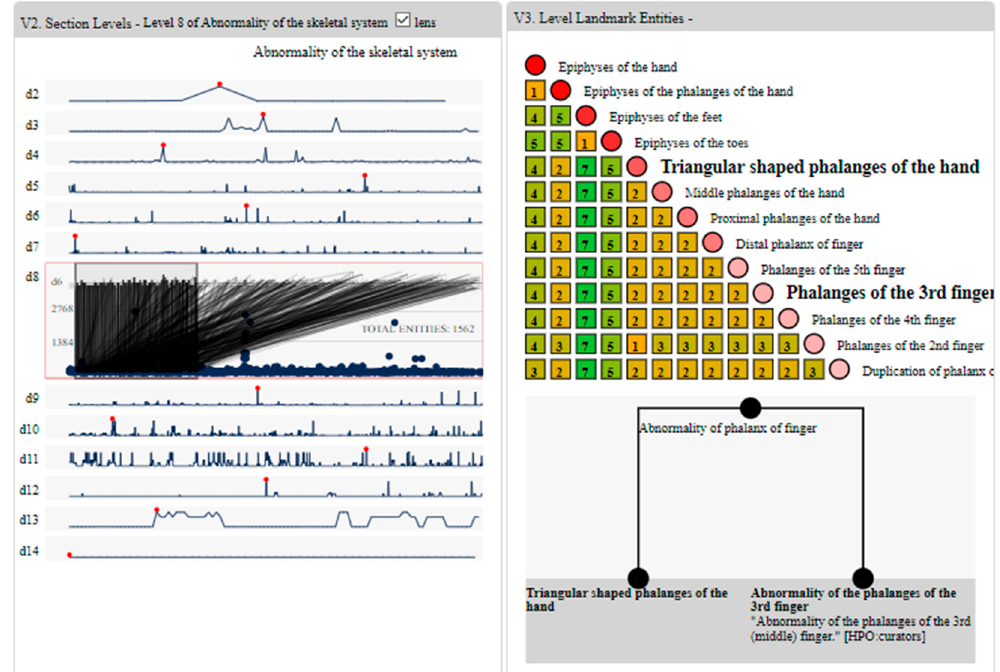
Figure 16. The Level Landmark Entities Panel depicting an ontology level with significant connectivity within its matrix representation. We can see, using the magic lens of the Section Levels Panel, that the level has countless numbers of ontology entities and relations, which have been analyzed and presented in a usable manner with the Level Landmark Entities Panel. Within the matrix representation, each ontology entity is represented as a circle accompanied by a text label. Each circle maintains a red to white fill encoding reflecting its importance calculation, red being the most inherited, and white being the least. When we move our cursor over a circle, the text label grows and boldens for rapid association between the matrix position and its row and column labels. A color spectrum and text label is provided at the intersection points of the matrix representing ontological distance. This distance calculation is determined by the number of inheritances performed when defining the ontologies up to their nearest common parentage. For example, when a matrix position reflects the intersection between two ontology entities which inherit from the same immediate parent, their distance will be calculated and displayed as 2.